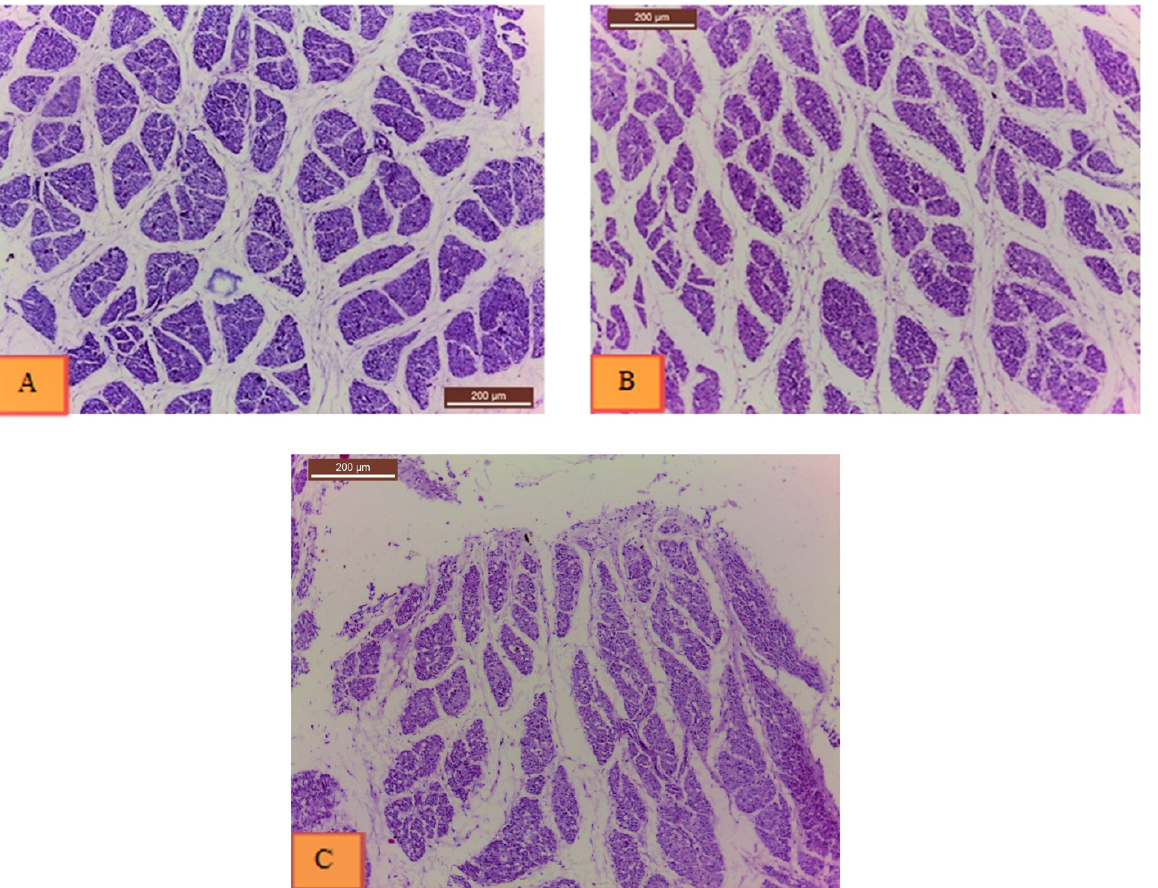
Figure 3. Histological slides from ( A ) non-injected control group, ( B ) treatment I (20 ppm Nano-Ag), and ( C ) treatment II (40 ppm Nano-Ag). Histological examination indicated 31.4% increase in the number of muscle fibers (hyperplasia) in treatment I, and larger average size of muscle fibers in treatment II (hypertrophy) (12.45 ± 1.74 µm²). Table 4. Least square means and their standard errors for the effect of treatment (Nano-Ag with 20 ppm and 40 ppm) on the count, cross-sectional area (µm²), average size (µm²), and % area of muscle fibers from breast muscle samples of day 18 of incubation, ( n = 3 samples from each group, 3 sections from each sample, 9 sections for each group). Group Count * Cross-Sectional Area * (µm²) Average Size* (µm²) % Area * Non-injected control 3283.22 b ± 300.08